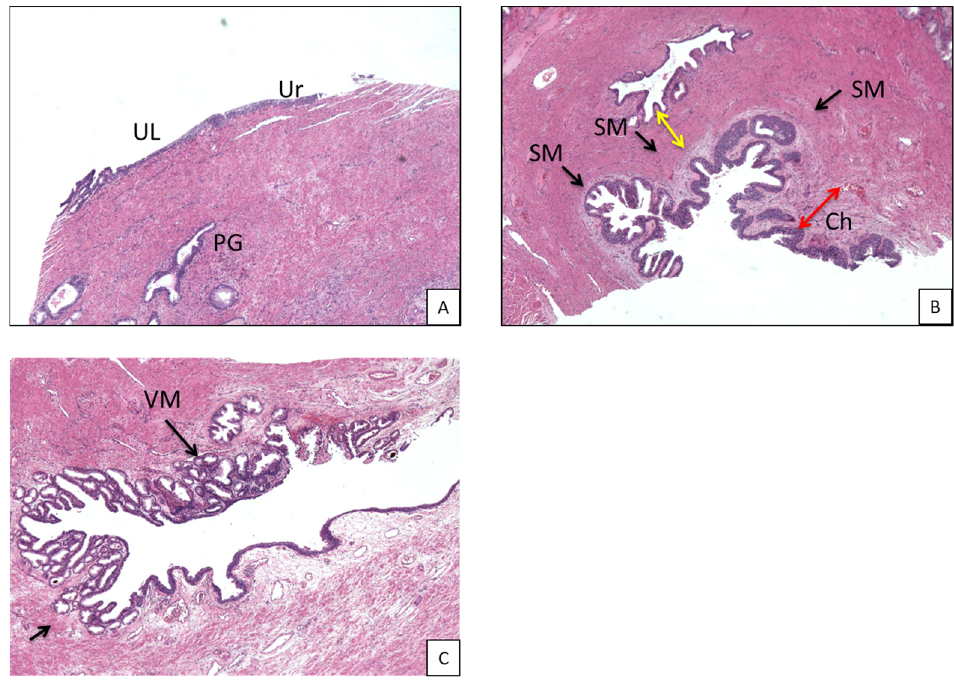
Figure 2. ( A ) Representative section of prebasal portion of prostatic urethra (H&E, 4 × magnification). ( B ) Representative section of prebasal portion of prostatic urethra: fibromuscular tissue is well represented and fibers are disposed in a sleeve around the urethra (arrow), as a continuation of detrusor muscle (H&E, 4 × magnification); red double arrow indicates chorion; yellow double arrow indicates distance between chorion and prostatic glands. ( C ) Middle portion of urethra: in this picture part of the verumontanum is represented; seminal ducts are normally present and lay close to the prostatic urethra (arrows). UL, urethral lumen; Ur, urothelium; PG, prostatic glands; Ch, chorion; SM, smooth muscle; VM, verumontanum.